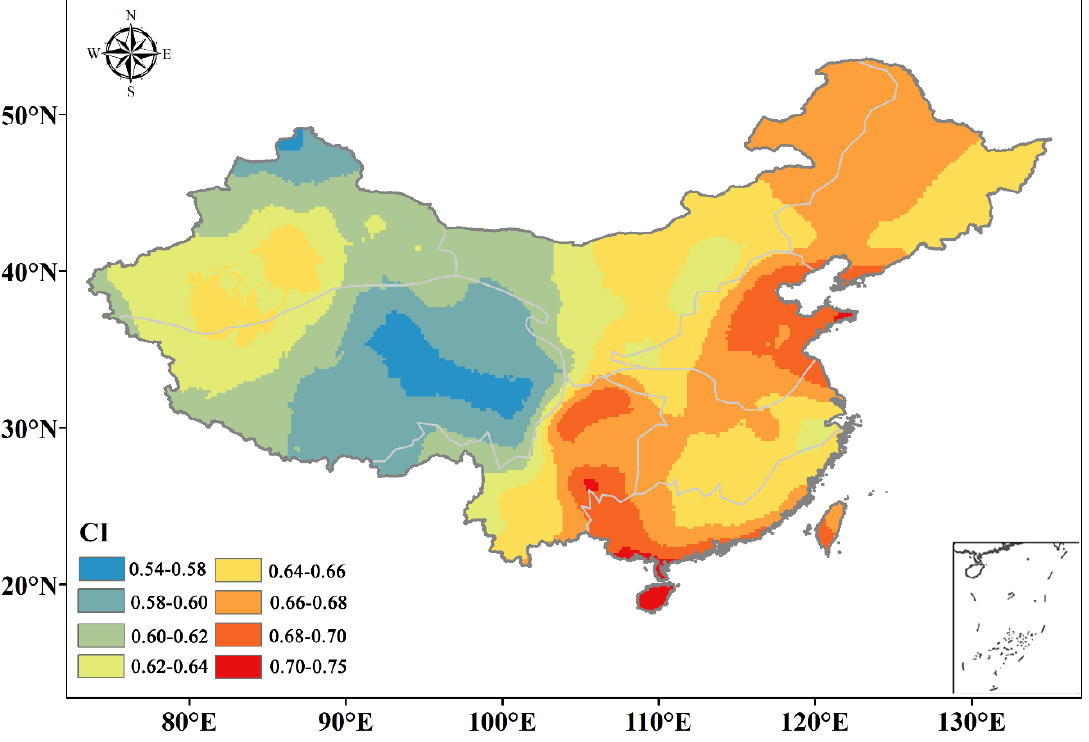
Figure 7. The spatial distribution of the mean annual concentration index (CI) across China.